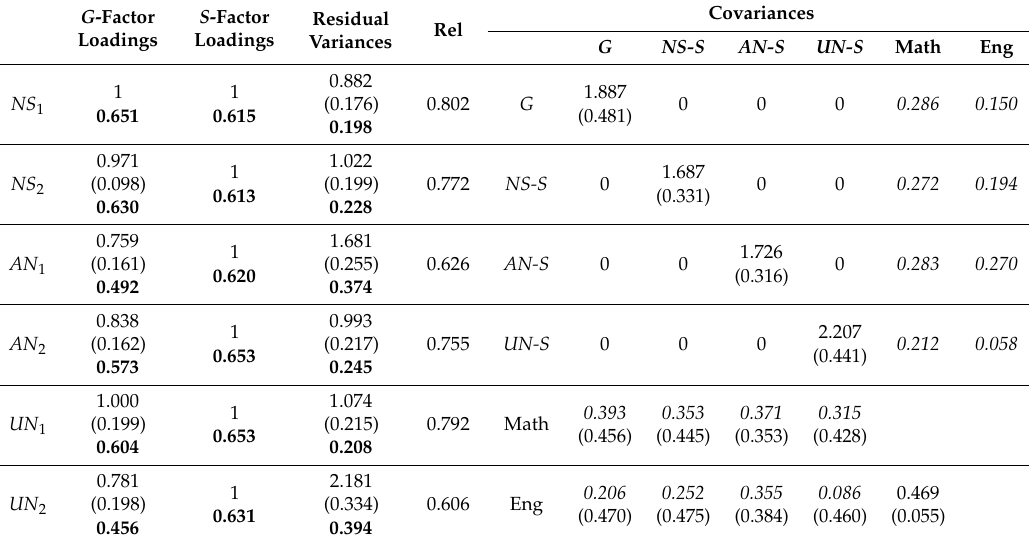
Table 2. Bifactor Model and